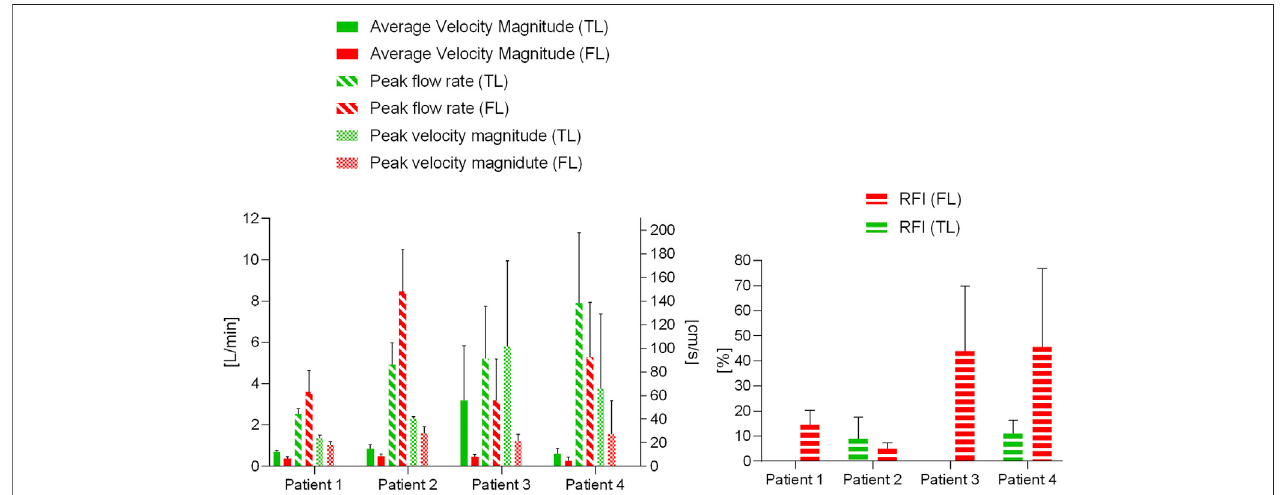
FIGURE 5 | Blood fl ow parameter variations for the four patients in the TL and FL. Average velocity magnitude, peak fl ow rate and peak velocity magnitude are plotted on the left, reverse fl ow index (RFI) variations are plotted on the right.